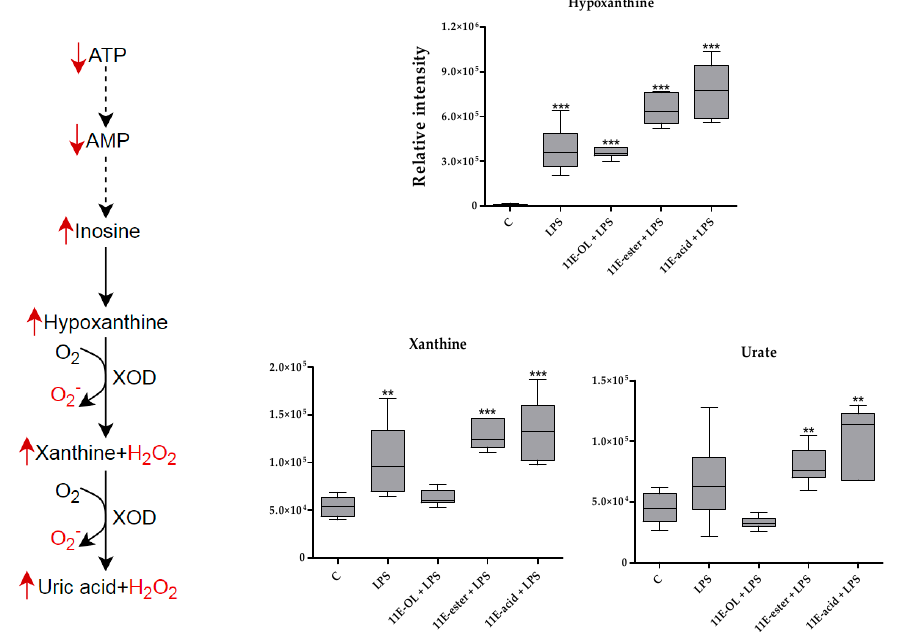
Figure 10. Schematic representation of the purine metabolism. This reflects how 11E-ester + LPS and 11E-acid + LPS synergise the effect of LPS alone focusing on hypoxanthine, xanthine and uric acid, which accumulated with H 2 O 2 and superoxide (O 2 − ) during purine degradations. C: Untreated control; LPS: Lipopolysaccharide; (11E-OH): (Z)-11-eicosenol; (11E-ester): Eicosenoate; (11E-acid): Eicosenoic acid; (Red rows): Response of 11E-ester + LPS and 11E-acid + LPS combination treatments; ATP: Adenosine triphosphate; AMP: Adenosine monophosphate; **: Significant ( p < 0.01); ***: Significant ( p <